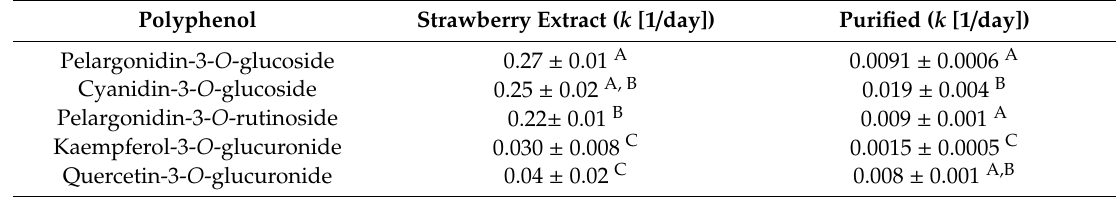
* Di ff erent capital letters represent di ff erences between structurally di ff erent polyphenols in